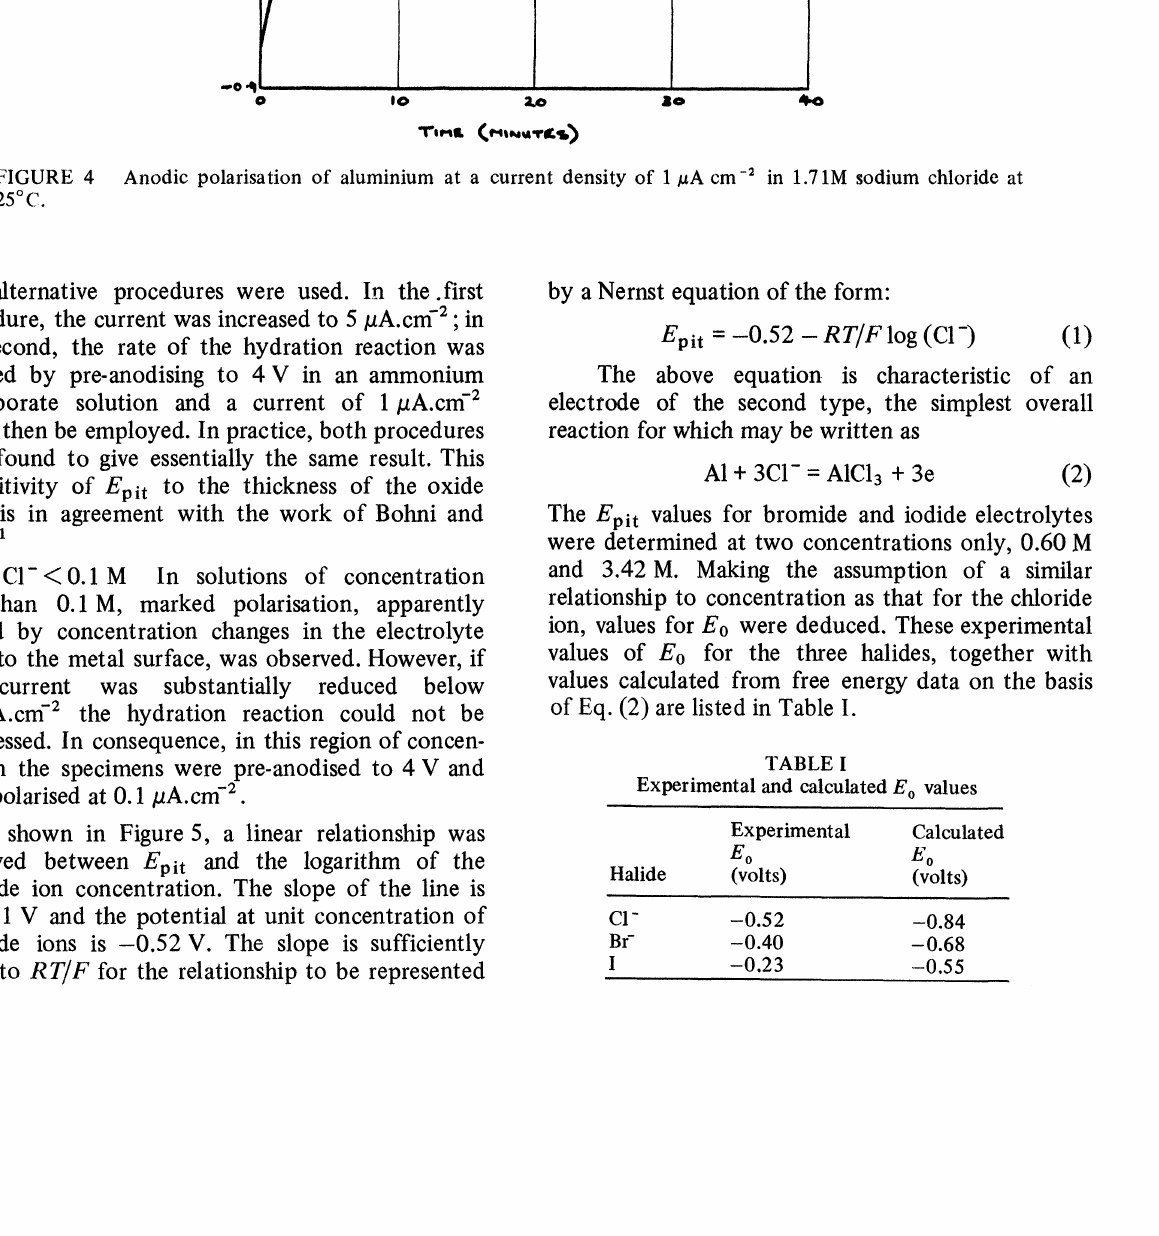
- in 1.71M sodium chloride at